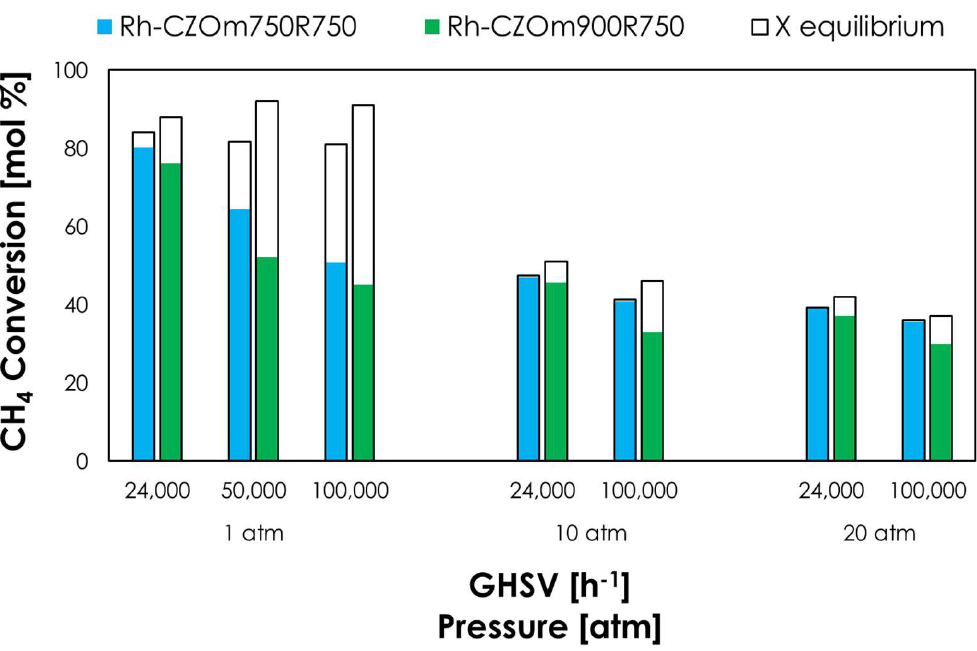
Figure 7. Methane conversion (colored bars) and equilibrium conversion (transparent bars) at 750 °C, S/C = 0.7, O/C = 0.2 and different pressures and GHSVs for Rh-CZOm750-R750 and Rh-CZOm900-R750.